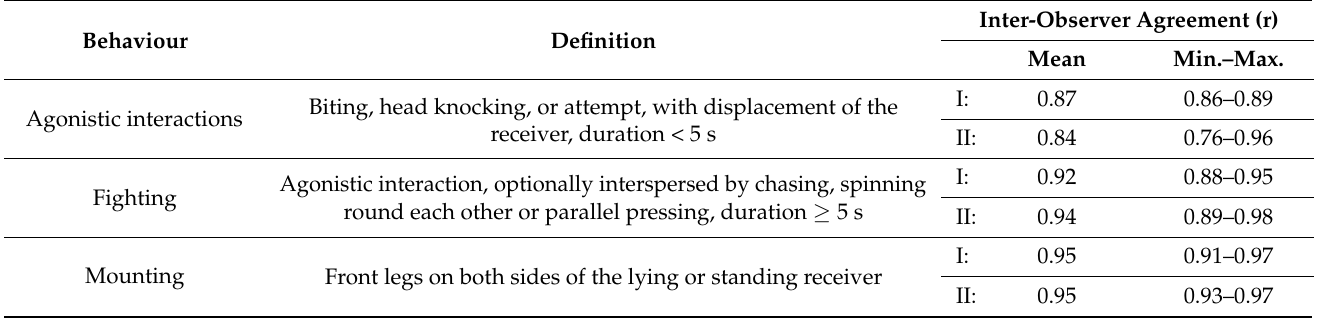
Table 2. Definitions of social interactions] and results of inter-observer reliability testing (Pearson correlation coefficient) between observers 1–3 (I) and observers 2–5 (II) using 12 video sequences of 15 min duration